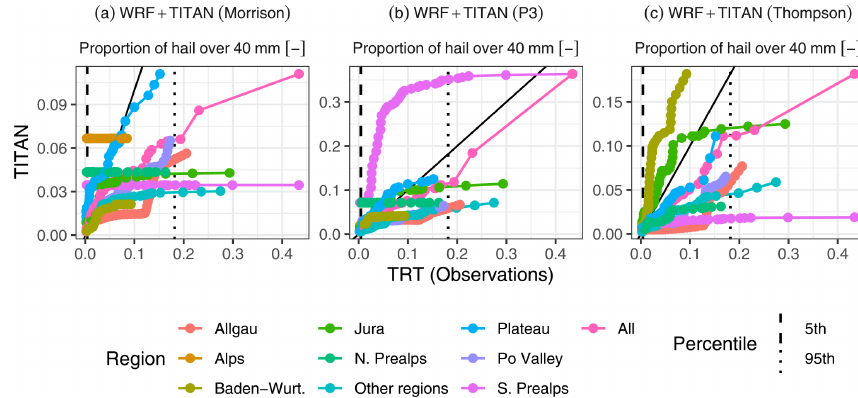
Figure 11. As for Fig. 10 but for maximum hail size over